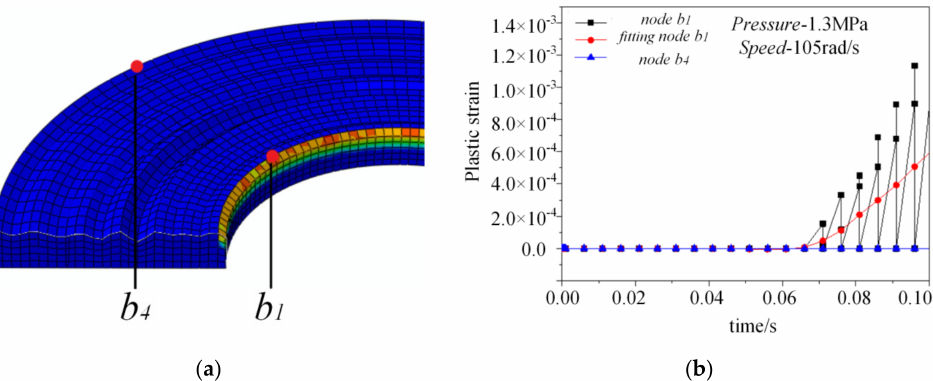
Figure 10. Plastic strain analysis for the upper part. ( a ) Reference nodes for plastic strain analysis. ( b ) Plastic strain curve of